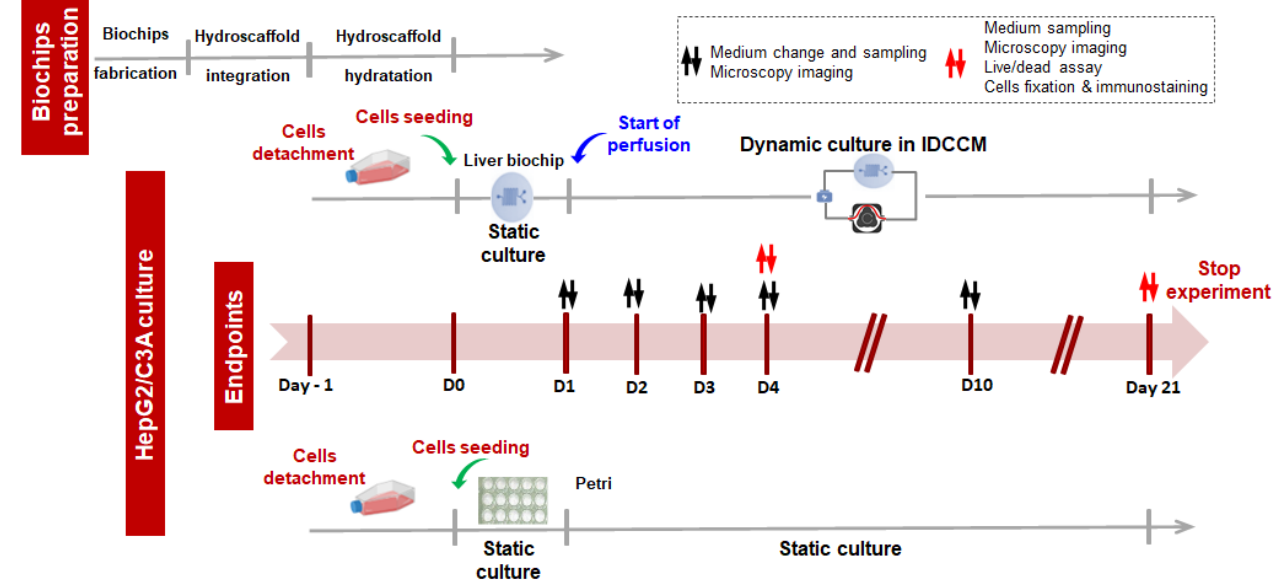
Figure 1. Experimental procedures used for HepG2/C3A cell culture in the biochip and Petri containing the HA-hydroscaffold.